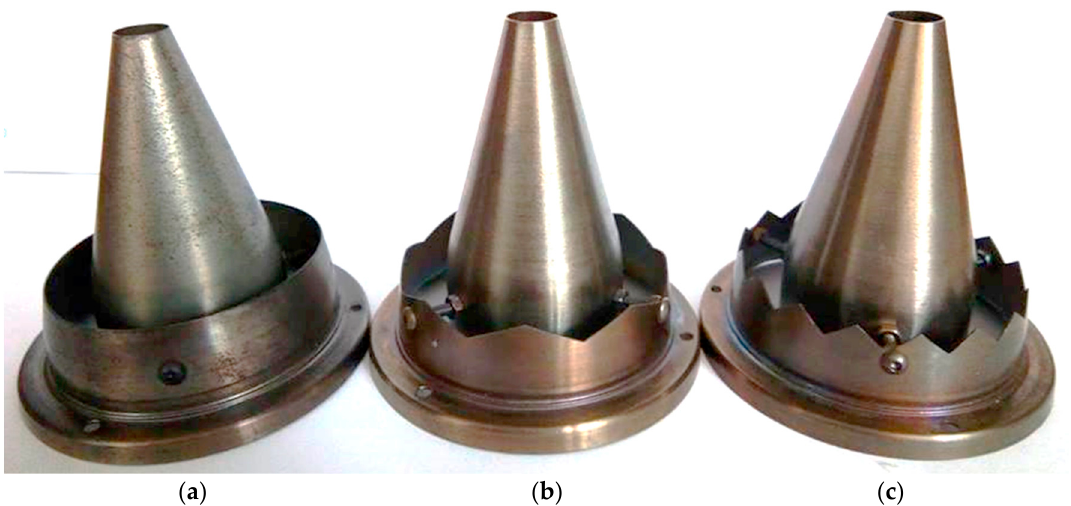
Figure 3. Nozzles tested configurations ( a ) references nozzle; ( b ) N8 L10 I0 nozzle ( c ) N16 L10 I0 nozzle.